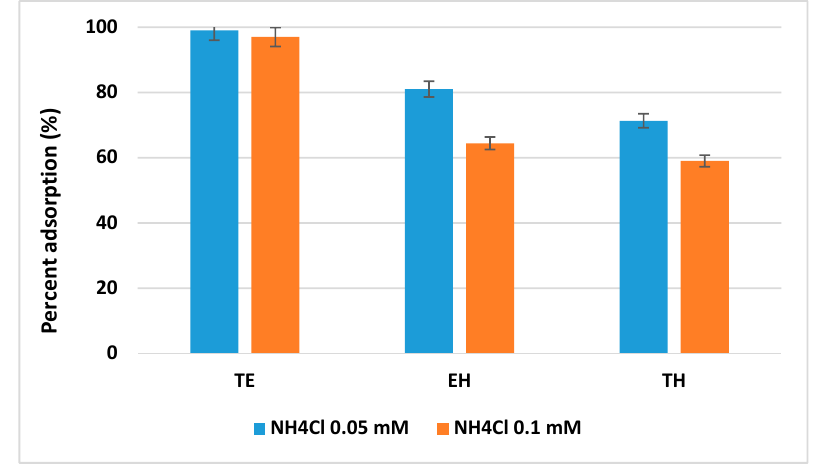
Figure 5. Percentage of the total amount of W adsorbed (TW ads ) at increasing ionic strengths for the three investigated soils.